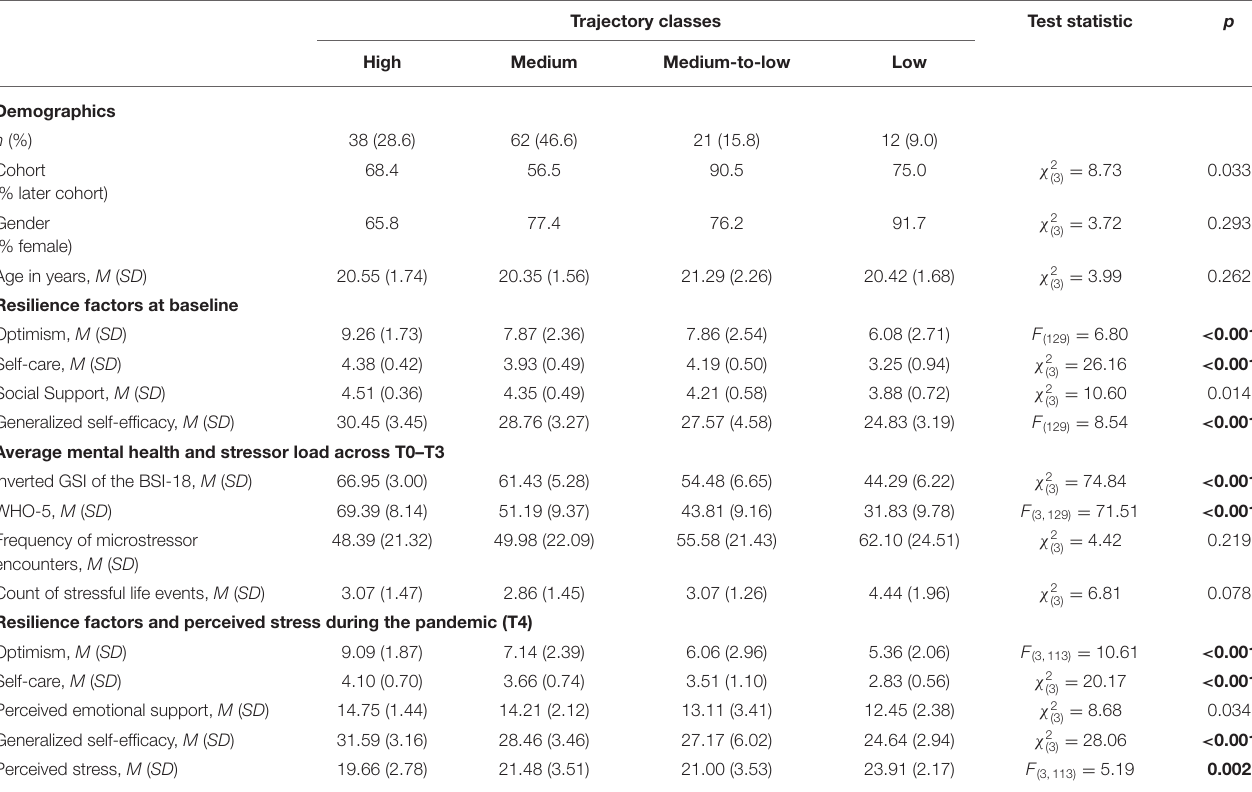
TABLE 2 | Demographics, resilience factors at baseline, average stress and mental health across T0-T3, and resilience factors and perceived stress during the pandemic by class.